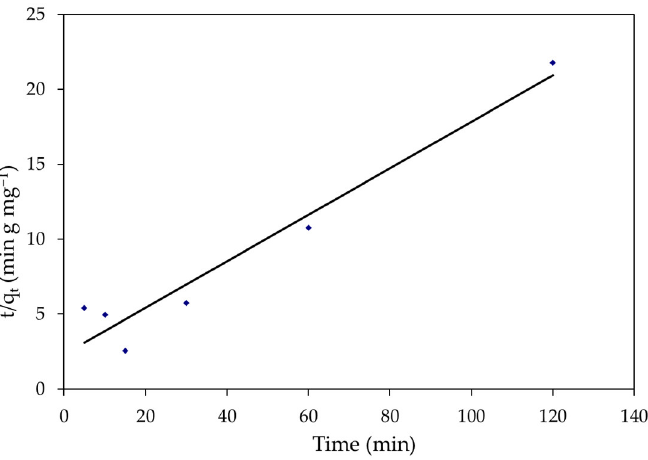
Figure 18. The pseudo-second-order for the elimination of MBD onto S. latifolium.